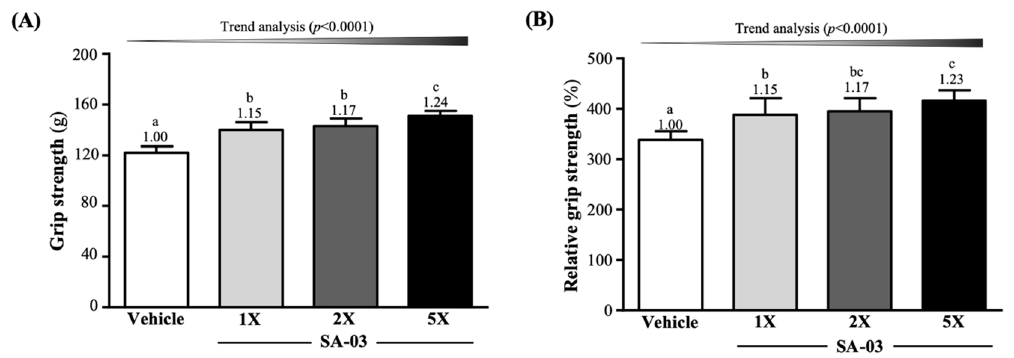
Figure 3. E ff ect of four weeks of SA-03 supplementation on ( A ) absolute forelimb grip strength and ( B ) forelimb grip strength (%) relative to body weight. Data are expressed as mean ± SD ( n = 10 mice per group). Di ff erent superscript letters (a, b, c) indicate significant di ff erence ( p <